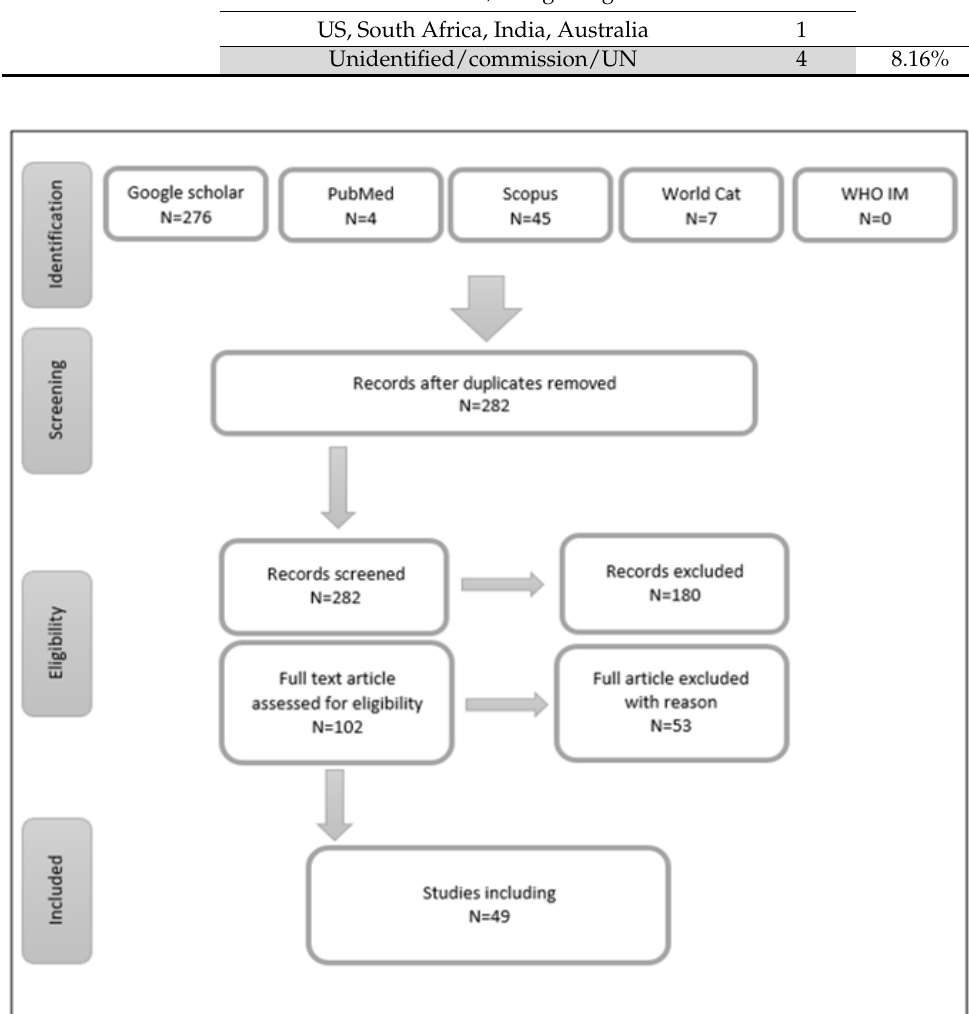
Figure 1. Search flow chart .